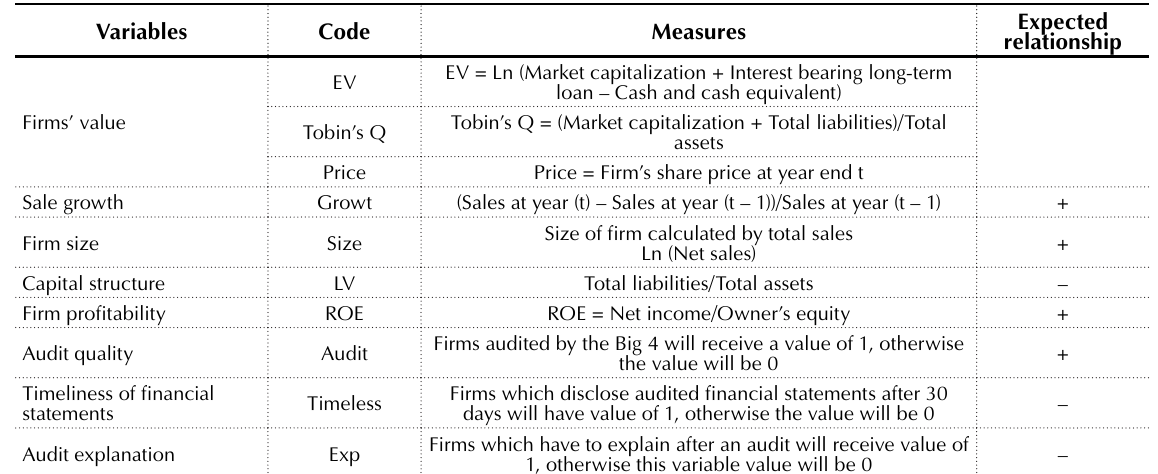
Table 1. Variables in the research model